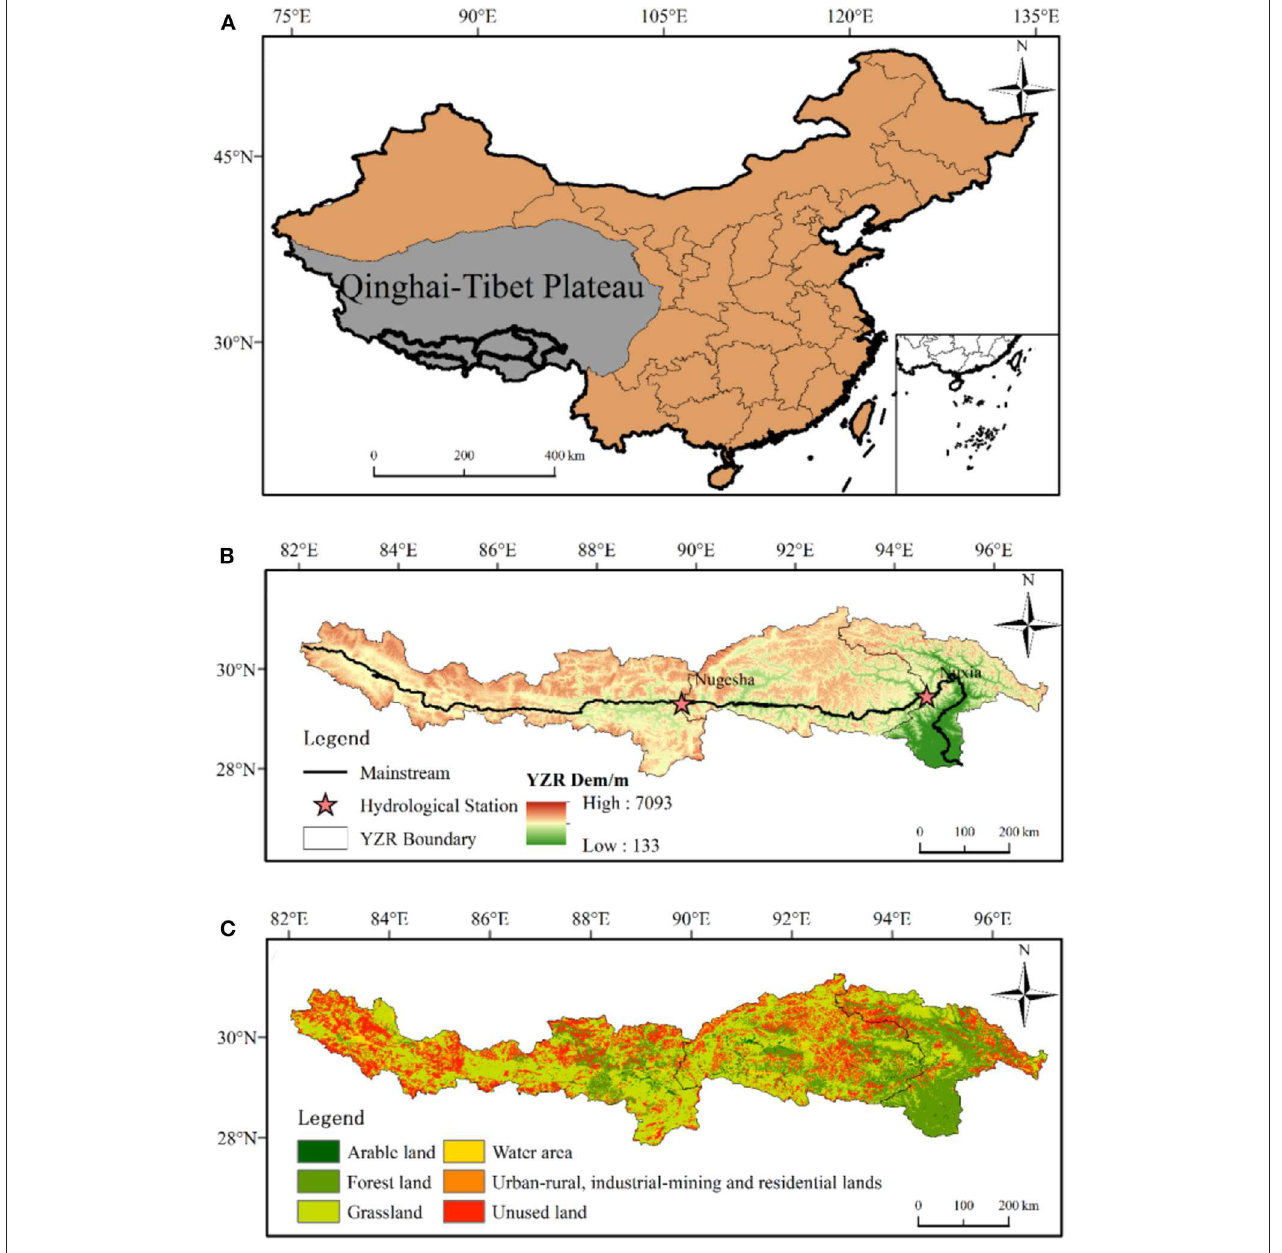
FIGURE 1 | The geographical location (A) , hydrometeorological stations (B) , and land use types of the Yarlung Zangbo River (YZR) basin (C)